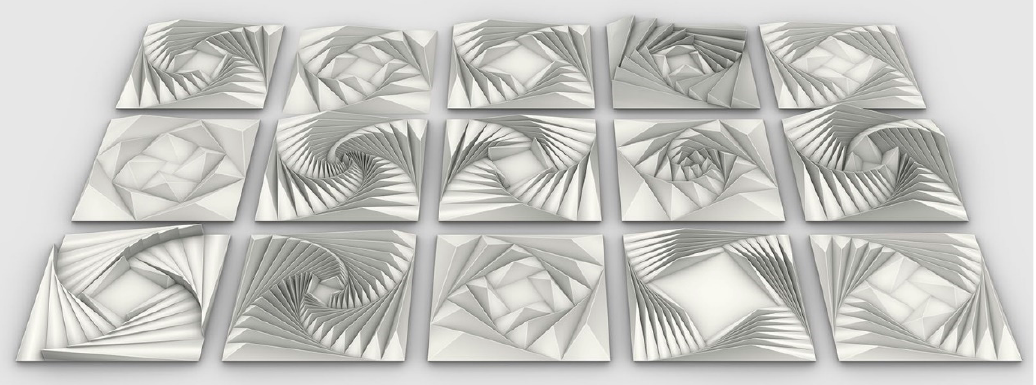
Figure 12. The results, generated by applying the transformation rule recursively ( 1 – 4 ) and the termination rule ( 5 ).